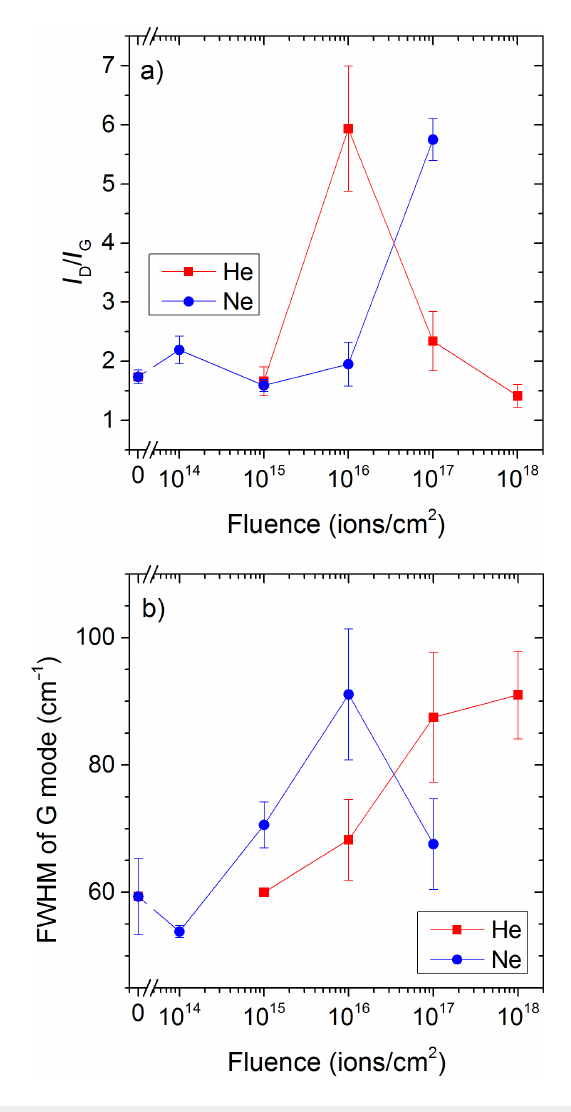
Figure 2: a) Ratio of intensities of D to G band as a function of fluence for 25 keV He and Ne irradiation, and b) full width at half maximum of the G band peak as a function of fluence for 25 keV He and Ne irradia- tion.